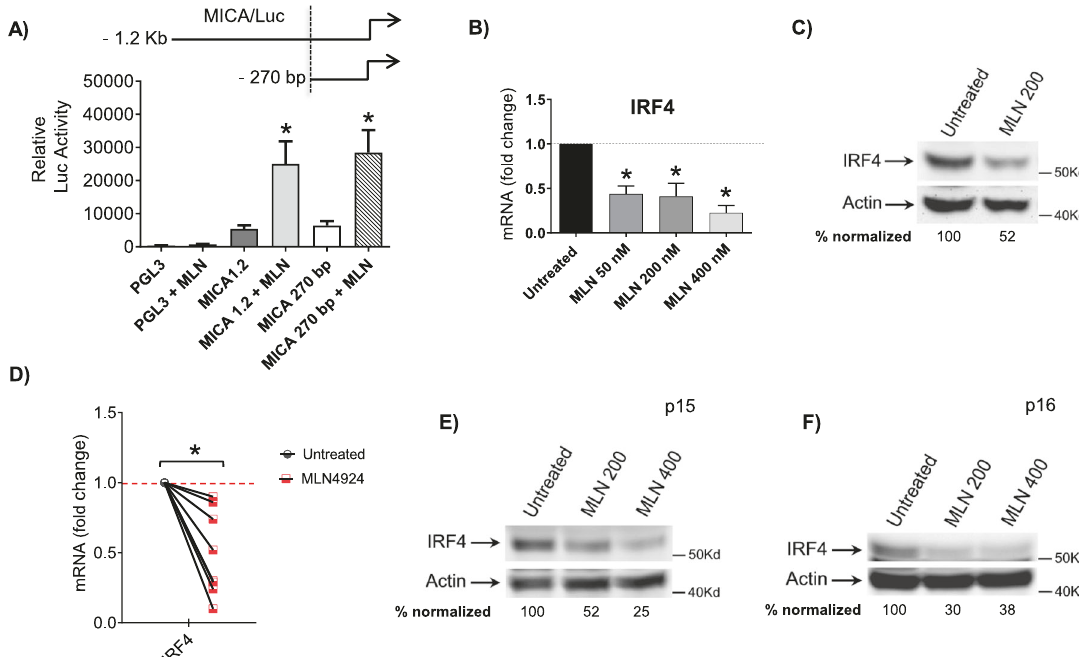
Fig. 5 The MICA gene promoter and the transcriptional repressor IRF4 are targets of NAE inhibition. A SKO-007(J3) cells were cotransfected with 5 µg of the indicated luciferase reporter vector and 1 µg of pRL-TK. After electroporation cells were treated with MLN4924 (200 nM) for 48 h, harvested and protein extracts were prepared for the Luciferase and Renilla assays. Results are expressed as Relative Luciferase activity normalized to protein concentration as well as to Renilla activity produced off the internal control plasmid and represent the mean value (±SEM) of four independent experiments (* P < 0.05). A schematic representation of the progressive MICA promoter deletions used in these experiments is shown. B Real-time PCR analysis of total mRNA obtained from SKO-007(J3) cells, untreated or treated with the indicated concentrations of MLN4924 for 48 h. Data, expressed as fold change units, were normalized to GAPDH, and were referred to the untreated sample considered as calibrator, represent the mean (±SEM) of four experiments (* P < 0.05). C Western-blot analysis of IRF4 in SKO- 007(J3) cells untreated or treated with MLN4924 for 48 h. β -Actin was used as protein-loading control. One representative western-blot out of three independent experiments is shown. Densitometric analysis of the reported Western blot is shown. D Real-time PCR analysis of total mRNA obtained from puri fi ed CD138 + cells untreated or treated with MLN4924 (400 nM) as described above for 48 h in complete medium supplemented with 20 ng/ml IL-3 and 2 ng/ml IL-6. Data expressed as fold change units, were normalized to GAPDH, and referred to